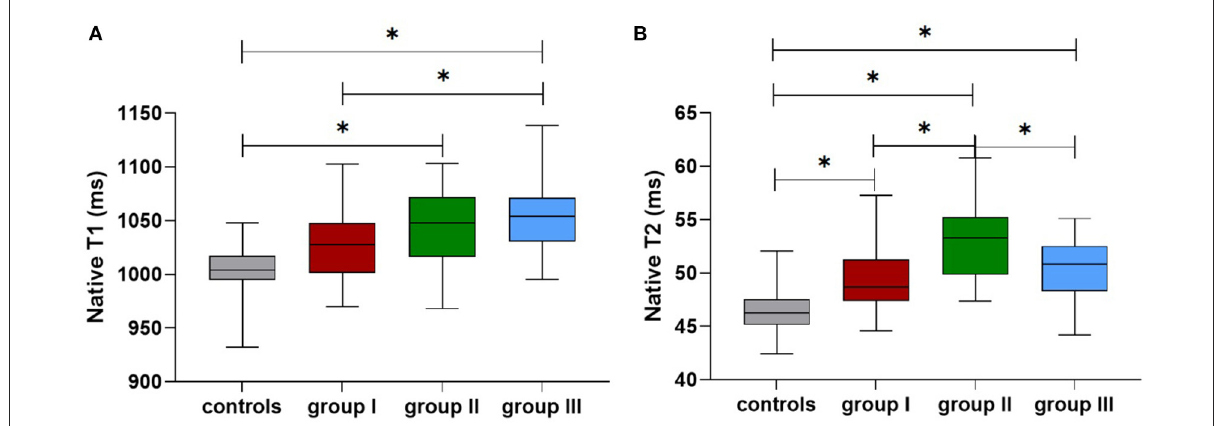
FIGURE4 Comparison of the native T1 (A) and T2 values (B) among the controls and groups I-III (*means that p < 0.05 between the two groups).